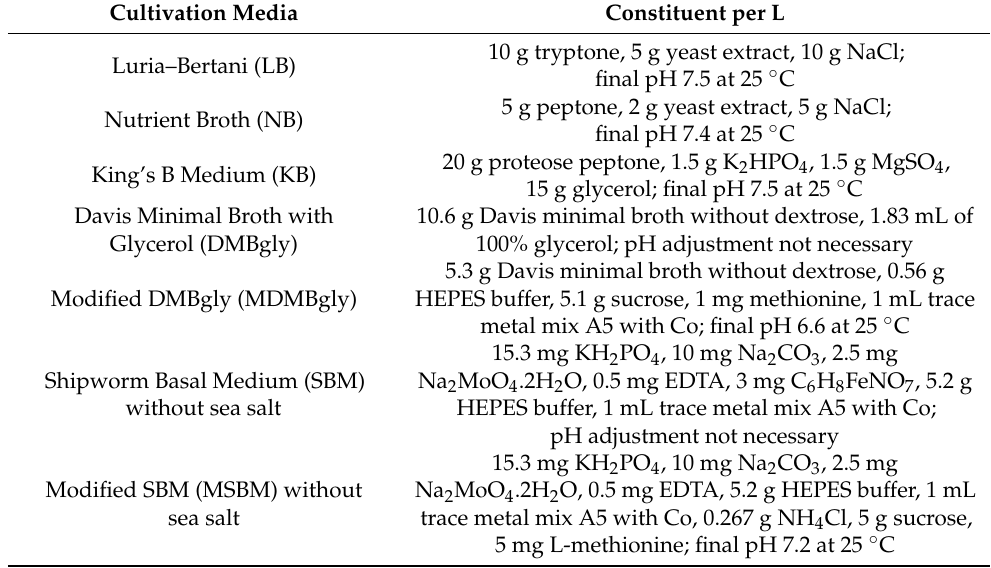
Table 1. Media used for Janthinobacterium